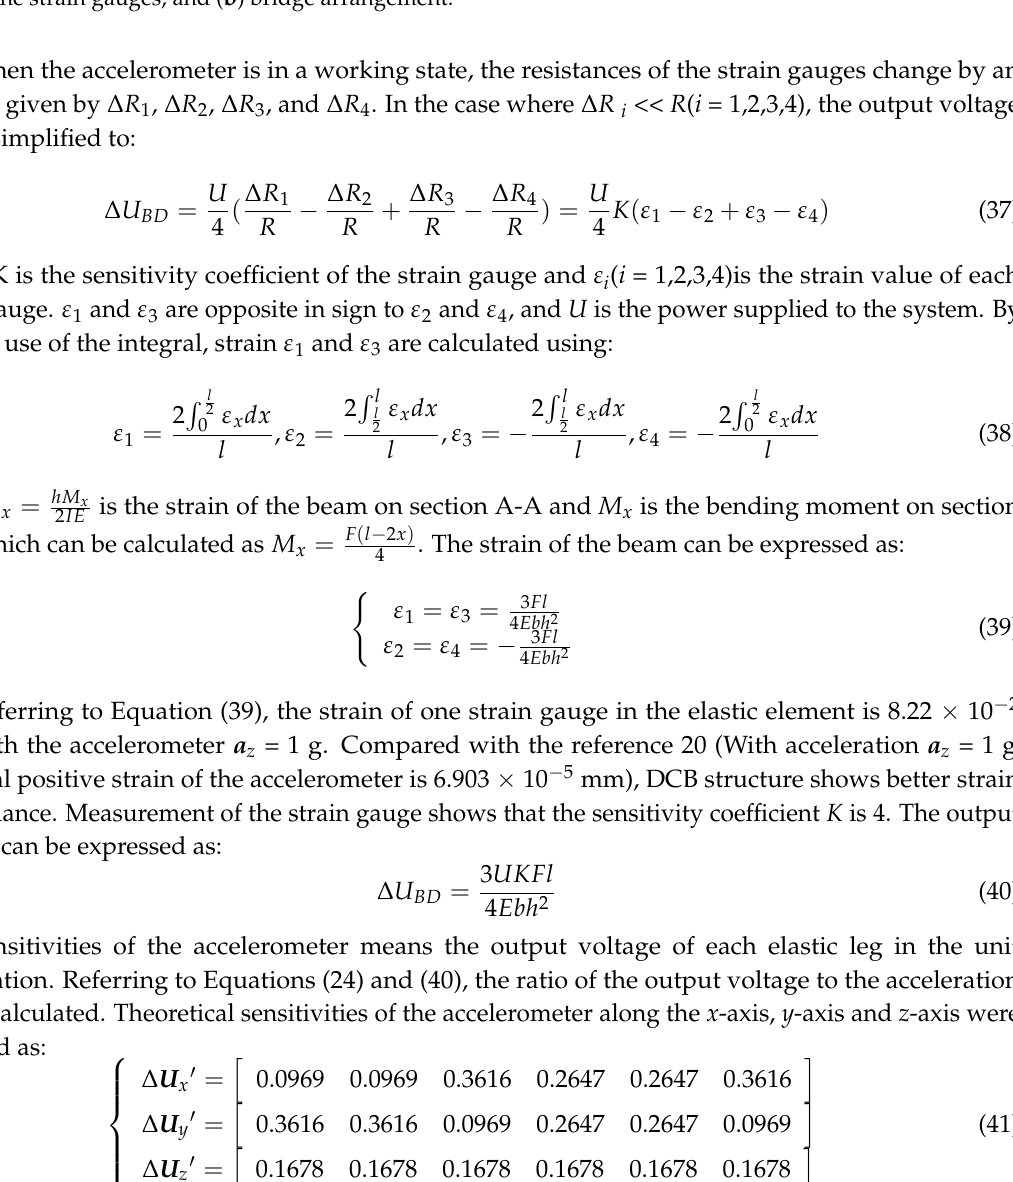
Figure 6. The location of the strain gauges and the bridge arrangement for one element: ( a ) the location of the strain gauges; and ( b ) bridge arrangement.